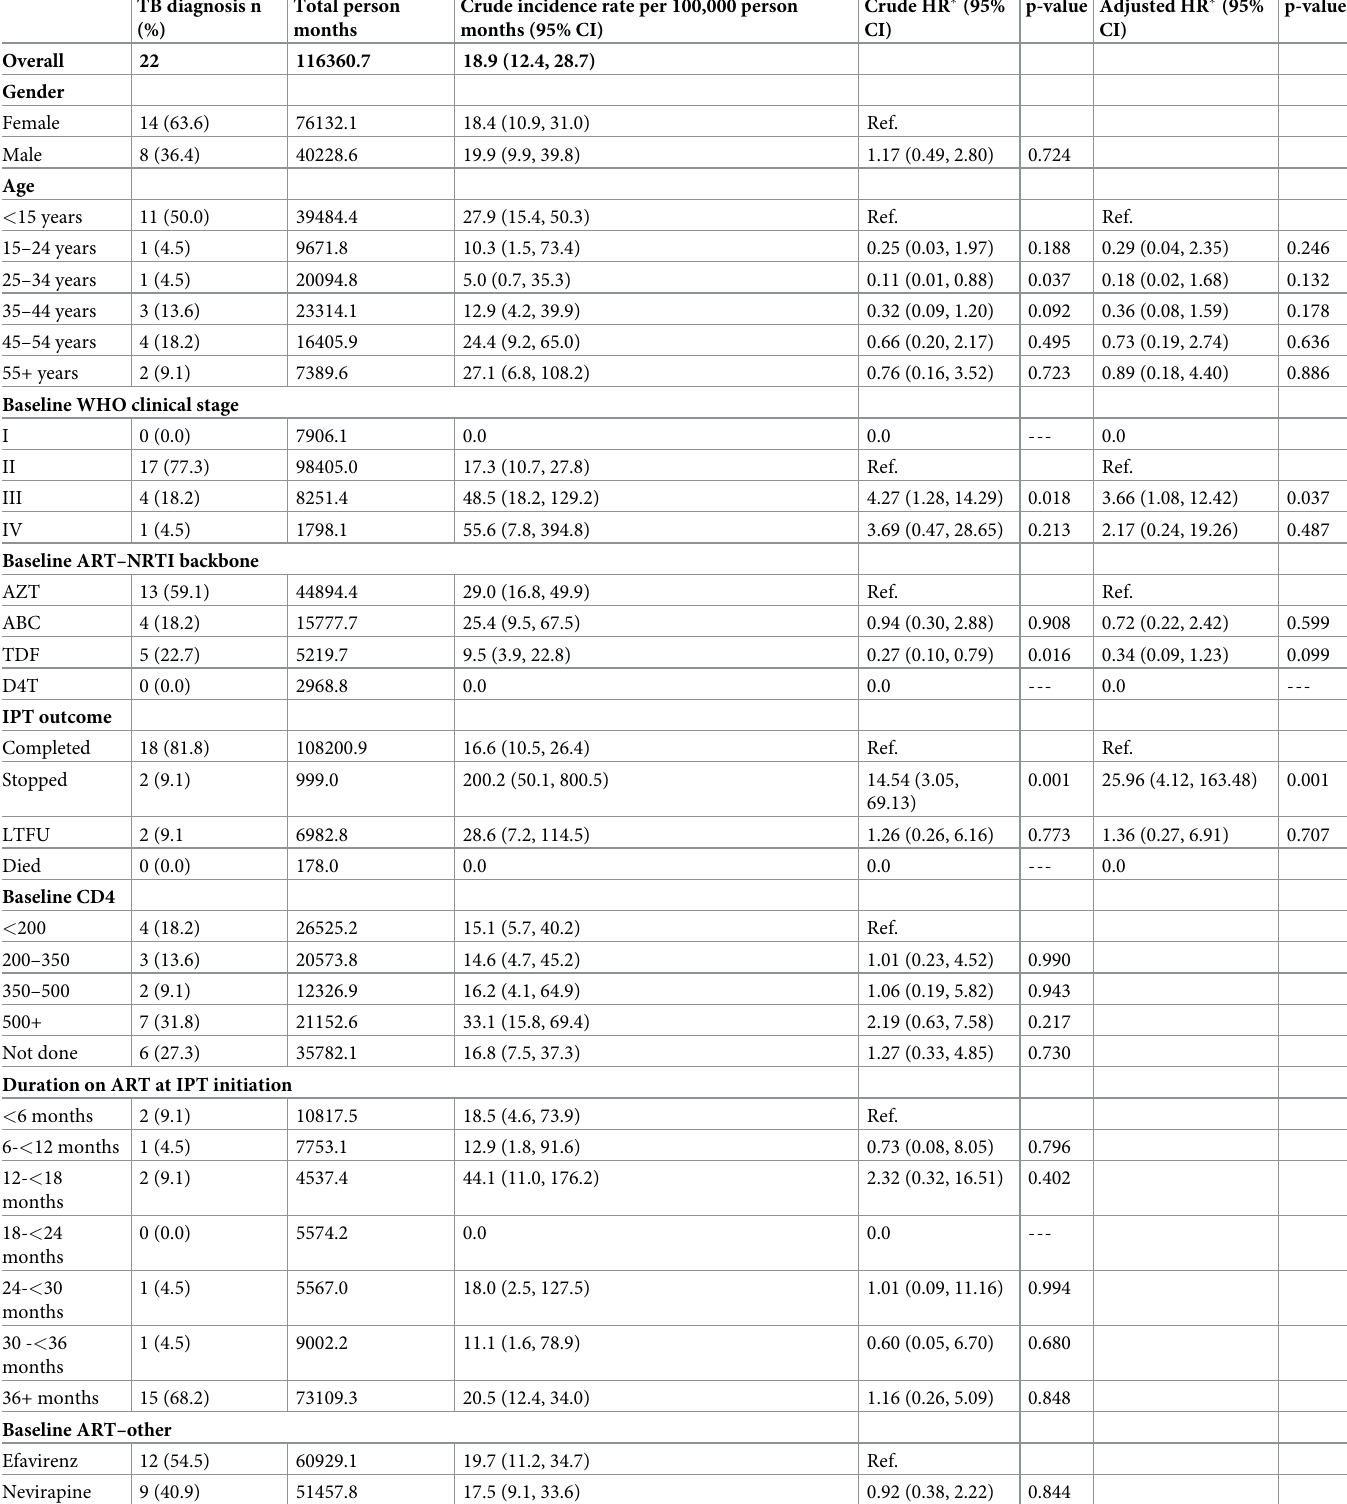
Table 3. Incidence of TB and associated